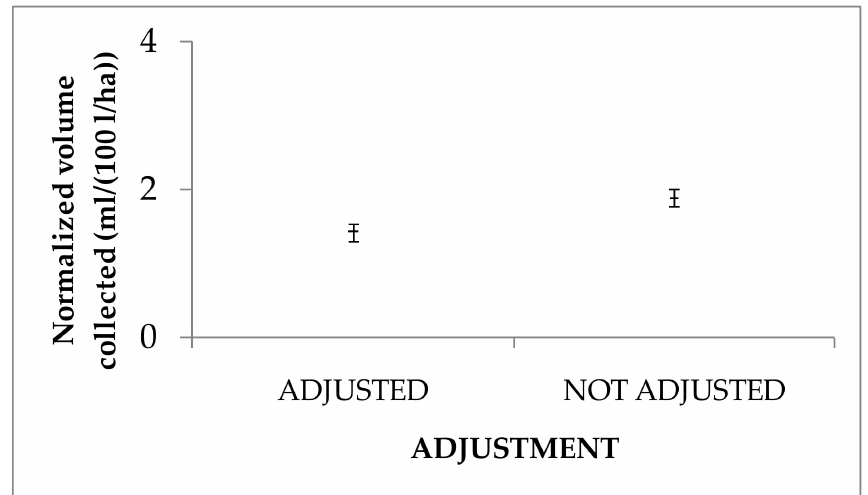
Figure 19. Adjustment effect on the normalized volume collected above the Canopy height (mean ± SE) with the C1 sprayer.